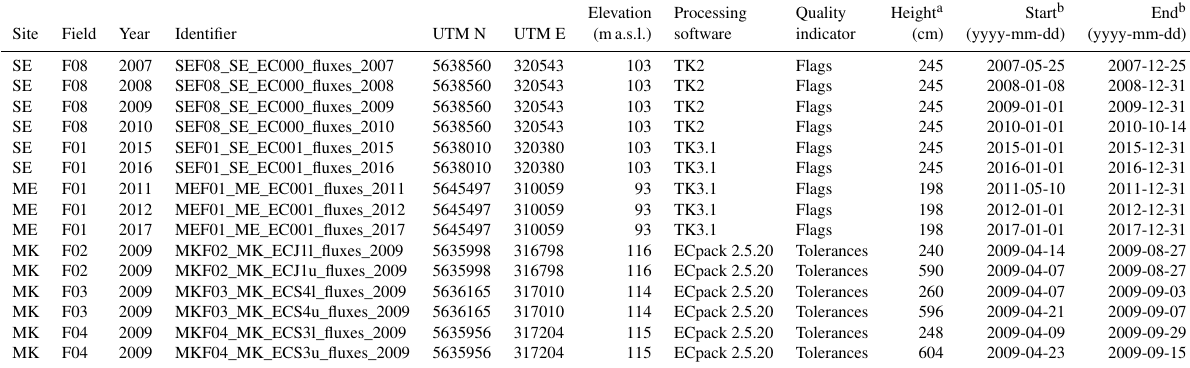
Table 5. Locations, processing software, instrument heights, and temporal extent of eddy covariance measurements. Coordinates are UTM zone 32N (WGS 1984). For information on quality indicators see Sect.